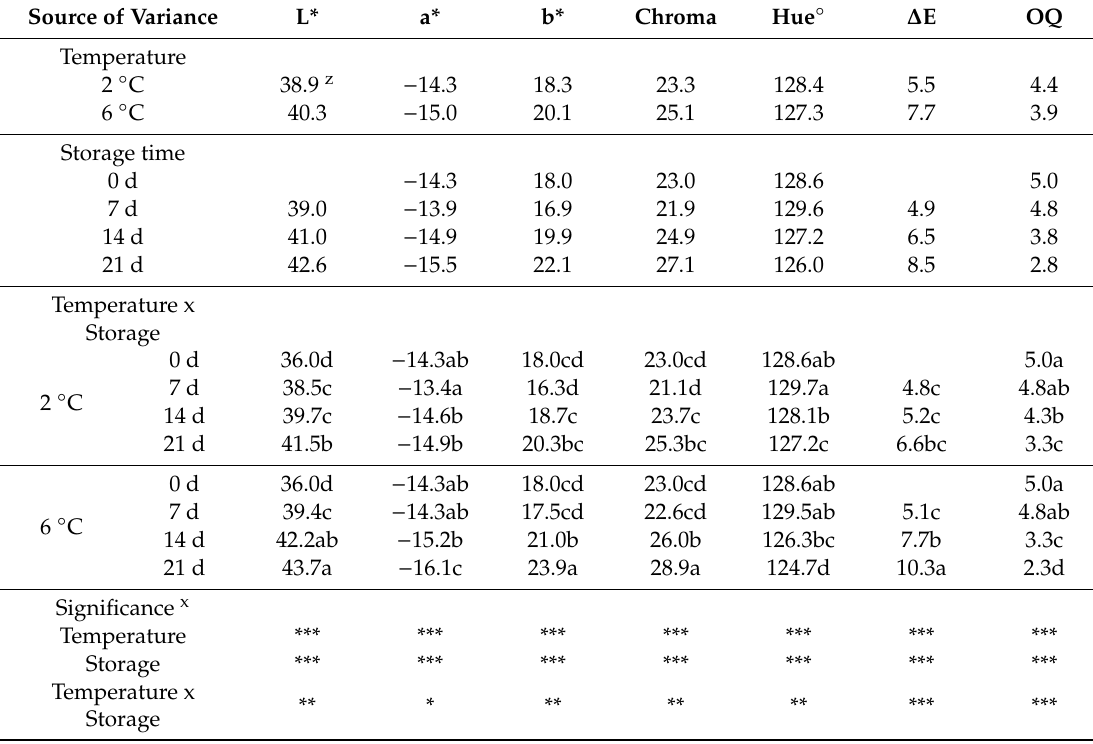
Table 2. E ff ect of temperature and time of storage on leaf appearance of minimally processed borage